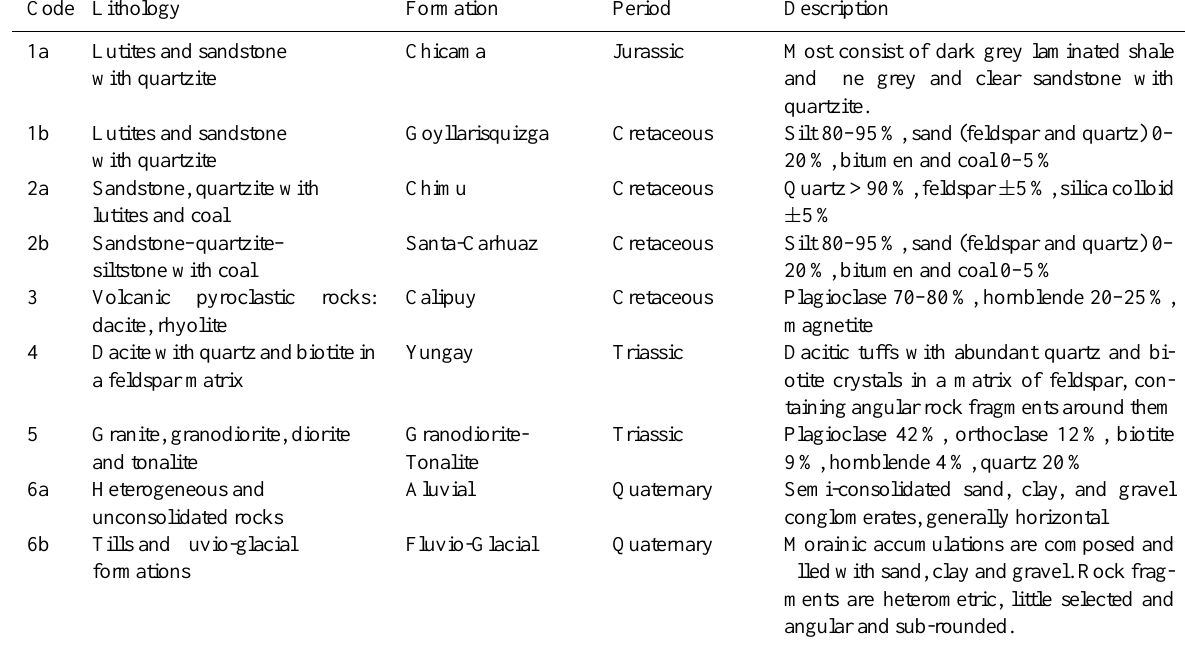
Table 1. Lithological typology in the study catchments. Code Lithology Formation Period Description Chicama Jurassic Most consist of dark grey laminated shale and fine grey and clear sandstone with